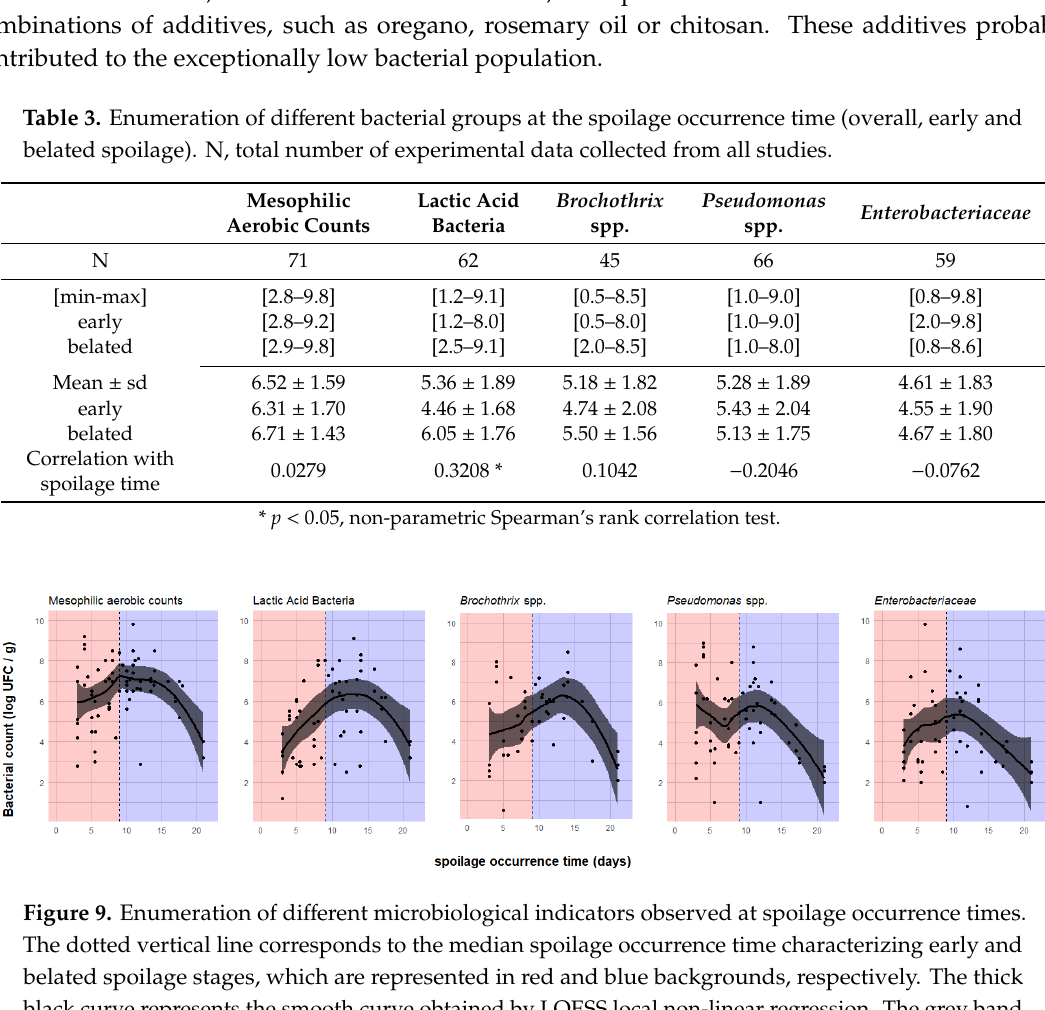
Table 3. Enumeration of different bacterial groups at the spoilage occurrence time (overall, early and belated spoilage). N, total number of experimental data collected from all studies.